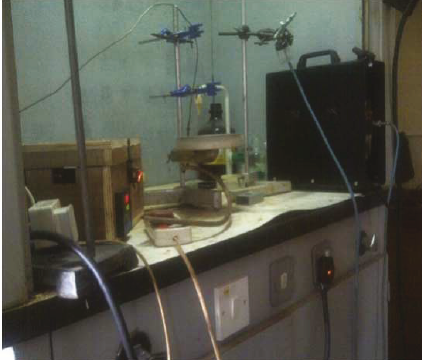
Figure 2: Pictorial representation of the experimental set-up of the spray pyrolysis